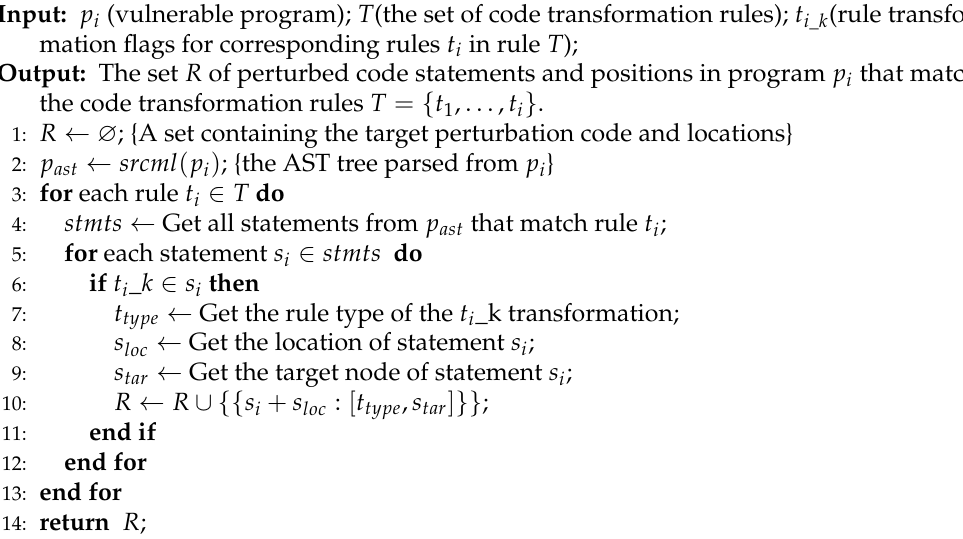
Algorithm 1 Extracting perturbation statements that match the transformation